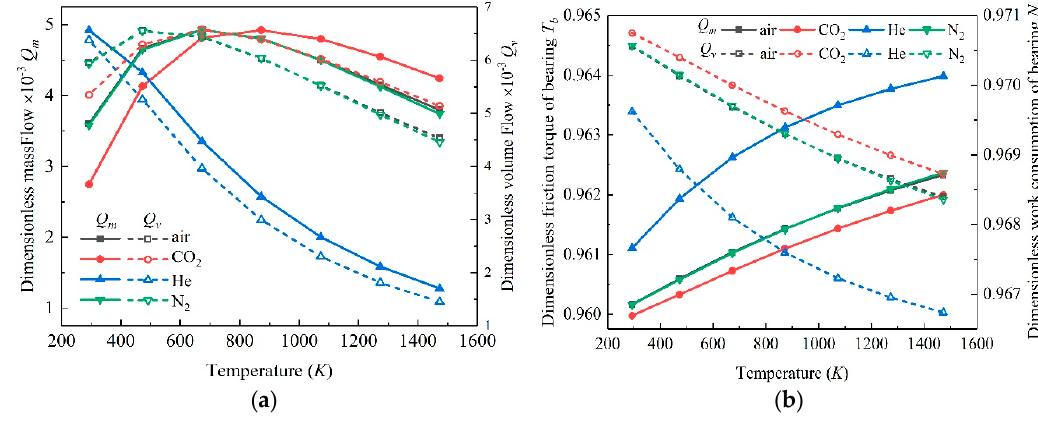
Figure 7. Influence of temperature on flow ( a ) and friction characteristics ( b ).